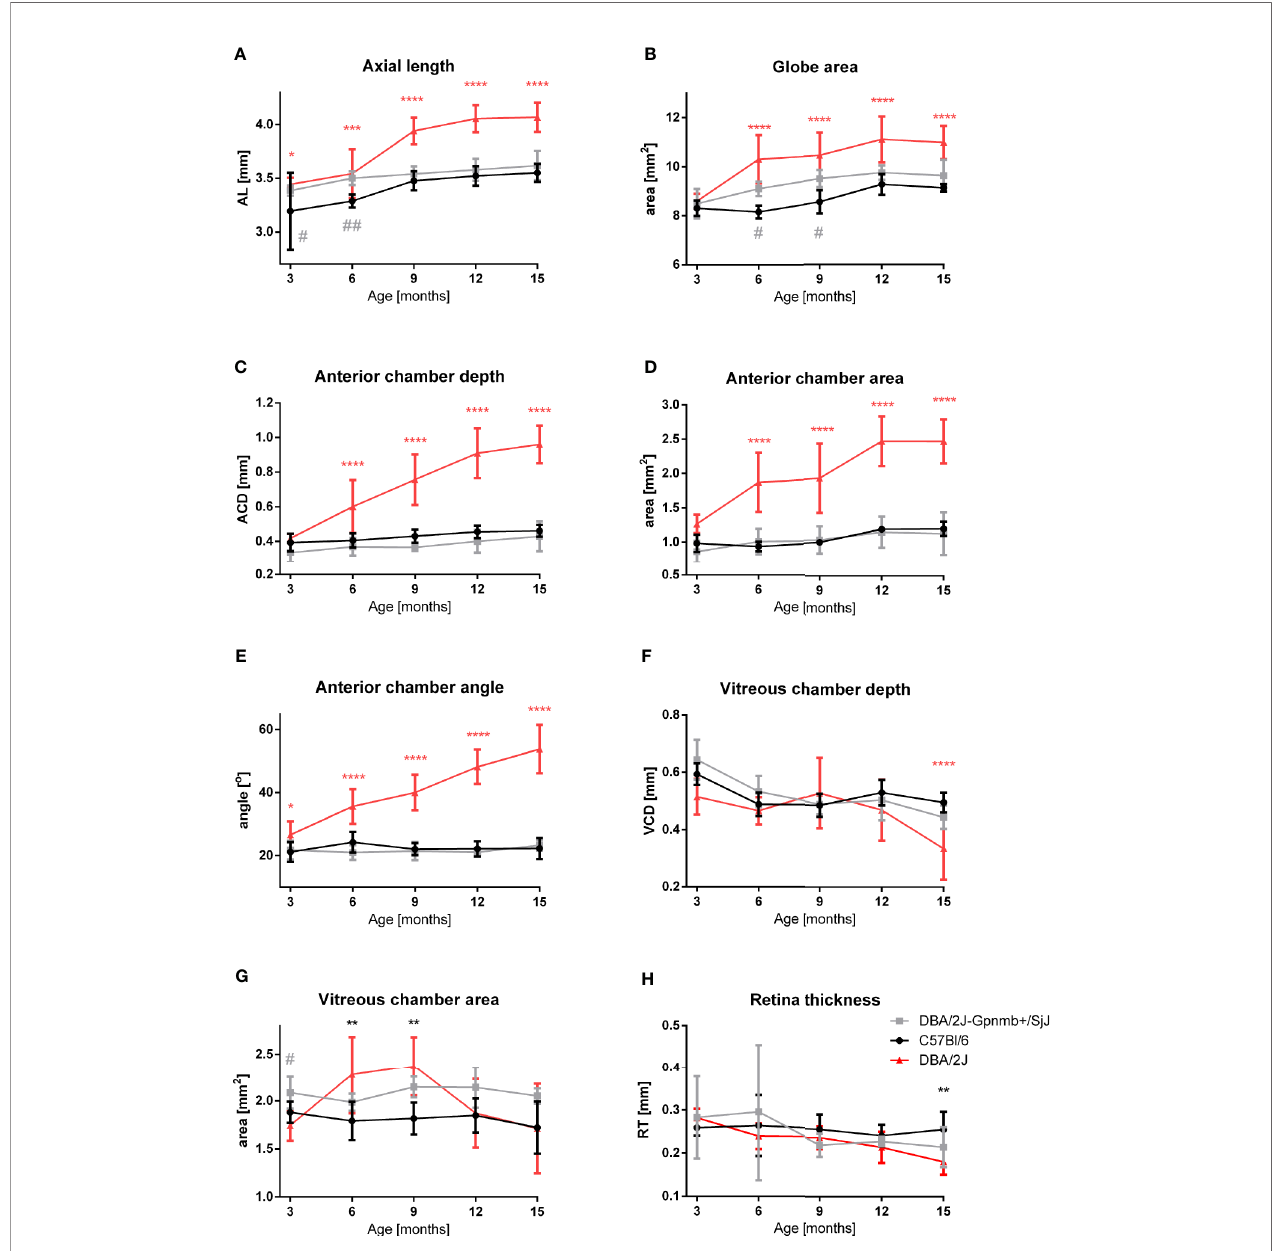
FIGURE 3 | Quantitative analysis of eye morphology in C57BL/6J, DBA/2J-Gpnmb+/SjJ, and DBA/2J mice. (A) axial length, (B) globe area, (C) anterior chamber depth, (D) anterior chamber area, (E) iridocorneal angle, (F) vitreous chamber depth, (G) vitreous chamber area, and (H) retinal thickness. Means ± SD. *P < 0.05, **P < 0.01, ***P < 0.001, ****P < 0.0001 DBA/2J vs. C57BL/6J; # P < 0.05, ## P < 0.01 DBA/2J-Gpnmb + /SjJ vs. C57BL/6J. Two-way ANOVA followed by Dunnet ’ s multiple comparisons